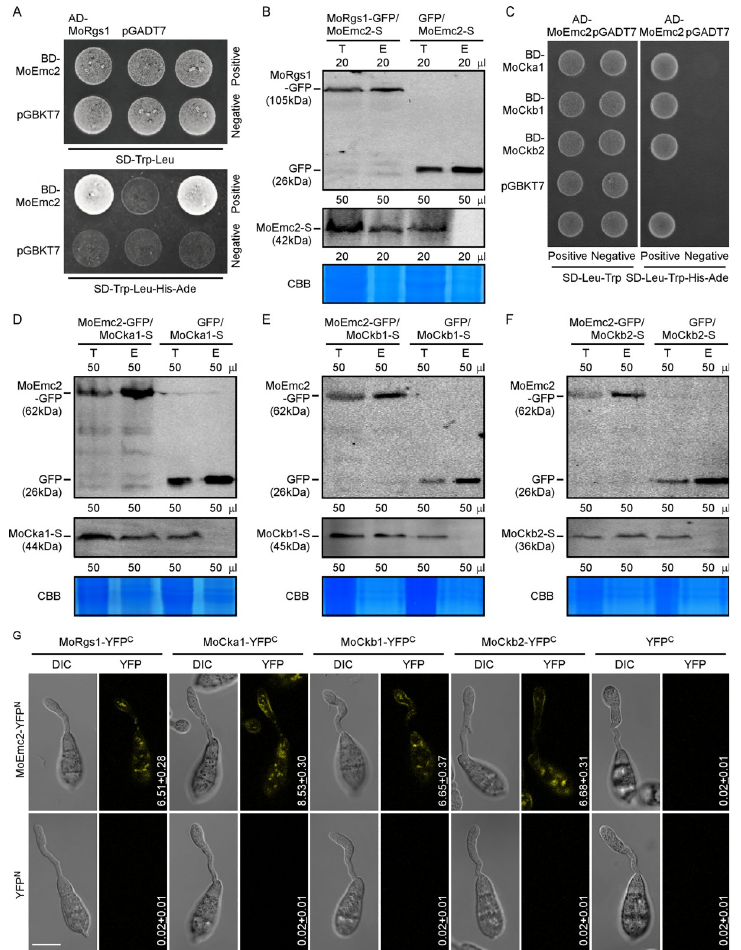
Fig 3. MoEmc2 interacts with MoRgs1 and MoCk2. (A) Y2H assays for examining interactions between AD-MoRgs1 and BD-MoEmc2. Yeast co-transformants expressing the bait and prey constructs were isolated on SD-Leu-Trp plate for 3 days and screened by culturing on SD-Ade-His-Leu-Trp plates for 5 days. (B) Co-IP assays for the interaction between MoRgs1-GFP with MoEmc2-S. GFP transformants were introduced into MoEmc2-S as a control. Total proteins were extracted individually as the total proteins, eluted from the anti-GFP agarose beads, and analyzed by Western blot with the anti-GFP or anti-S antibodies. CBB: Coomassie brilliant blue staining indicates loading controls. T: Total protein. E: Elution. (C) Y2H assays for examining the interaction among all three subunits of MoCk2 holoenzyme (BD-MoCka1, BD-MoCkb1, and BD-MoCkb2) with AD-MoEmc2. (D-F) Co-IP assays for interactions among all three subunits of MoCk2 holoenzyme (MoCka1-S, MoCkb1-S, and MoCkb2-S) with MoEmc2-GFP, respectively. GFP transformants were introduced into all three subunits of the MoCk2 holoenzyme (MoCka1-S, MoCkb1-S, and MoCkb2-S) as controls. CBB: Coomassie brilliant blue staining indicates loading controls. T: Total protein, E: Elution. (G) BiFC assays for interactions among all three subunits of MoCk2 holoenzyme (MoCka1-YFP C , MoCkb1-YFP C , and MoCkb2-YFP C ) and MoRgs1-YFP C with MoEmc2-YFP N . Empty YFP C and empty YFP N constructs were used as a negative control. Co-transformants were observed at the germ tube hooking stage (3 h after conidial suspension dropped onto the hydrophobic surface) with LSM (Zeiss LSM710 laser scanning microscope, 63 × oil, Bar = 10 μ m). The mean and SD of fluorescence intensity were denoted that calculated over 50 cells. All experiments were conducted with three biological repetitions and three